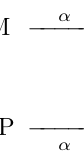
Figure 1. Schematic representation of interrelations of Wienerian processes (WP), L´evy processes (LP), quantum mechanics (QM) and fractional quantum mechanics